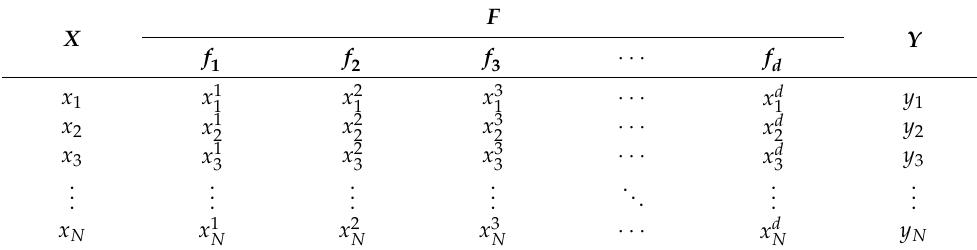
Table 1. Feature structure of a